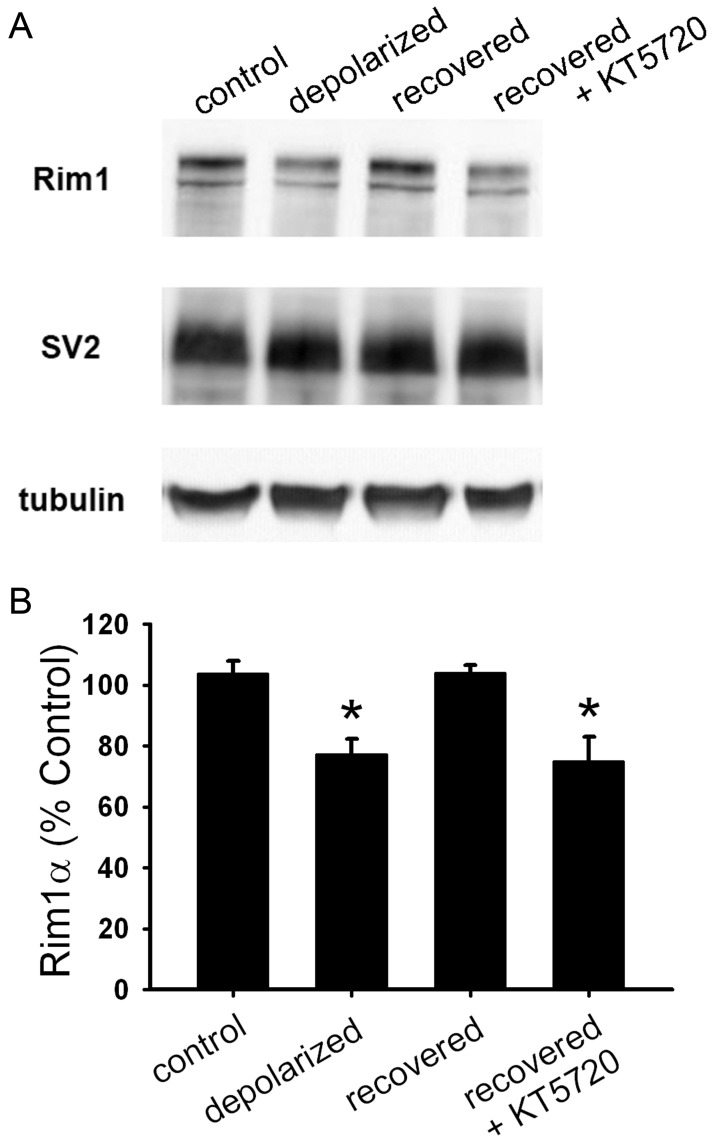
PKA signaling is required for recovery of Rim1 levels after depolarization-induced muting. A.Western blot analysis of whole-cell lysates from hippocampal mass cultures treated with 16 h 30 mM NaCl (control), 16 h 30 mM KCl (depolarized), or 16 h 30 mM KCl followed by 3 h recovery in fresh medium with (recovered+KT5720) or without (recovered) 2 µM KT5720. KT5720 was applied 0.5 h prior to and during recovery. B. Summary of Rim1 levels from Western blots as shown in A (n = 3). Rim1 protein levels for each condition were normalized to SV2 and control treatment. *p<0.05, Newman-Keuls post hoc test vs. control after one-way ANOVA.